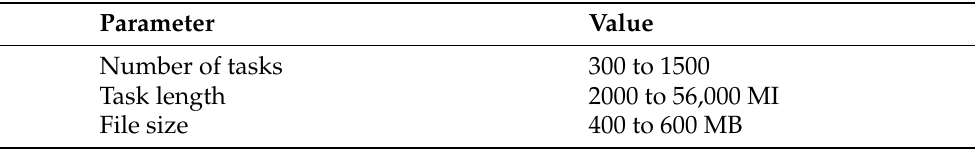
Table 8. Attributes of the synthetic